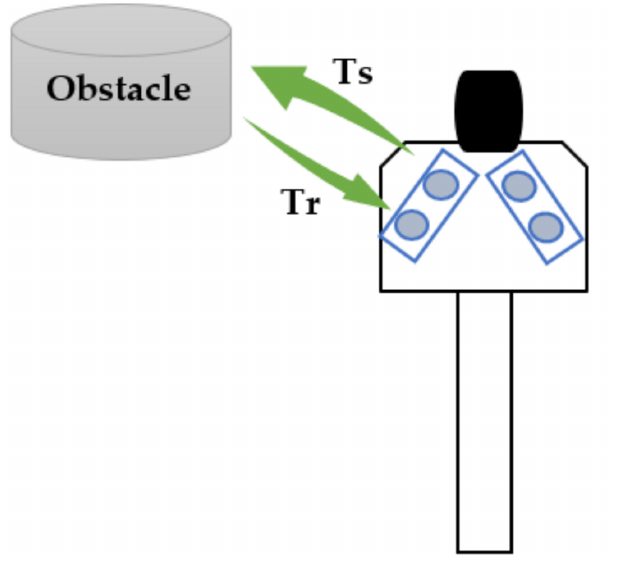
Figure 5. HC-S04 ultrasonic sensor from smart cane—sending and receiving signals: Ts —sending time, Tr —receiving